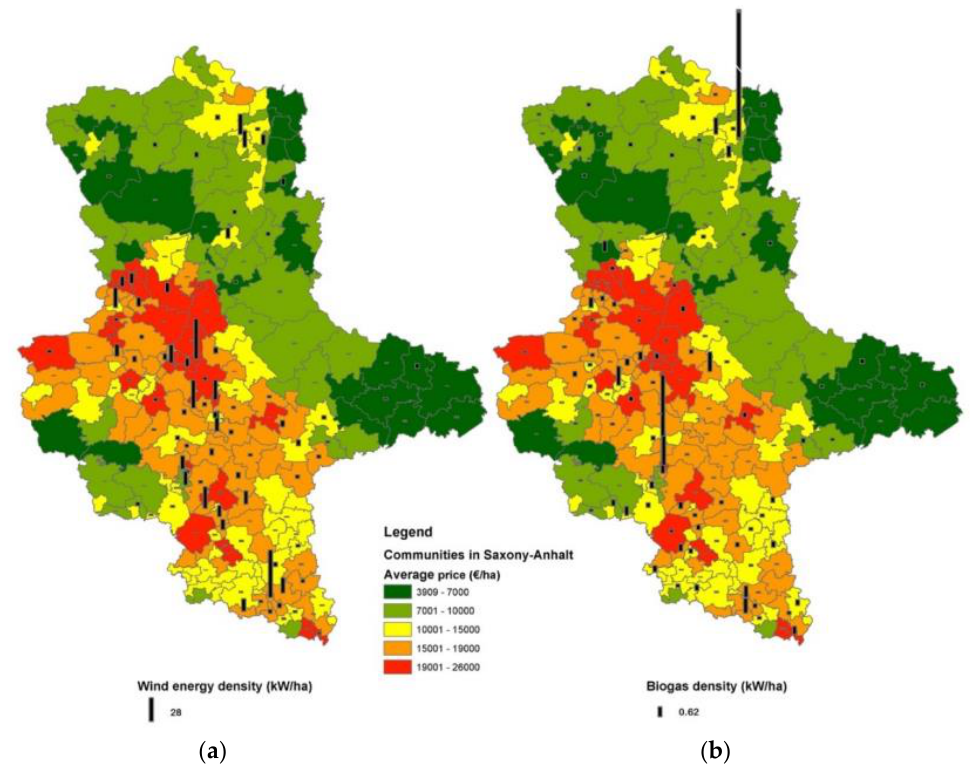
Figure 2. Average arable land prices and the number of wind turbines ( a ) and biogas plants ( b ) in communities of Saxony-Anhalt, 2007 – 2016.